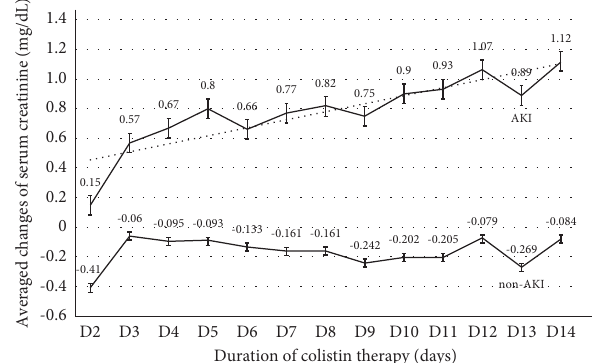
Figure 2: Means of serum creatinine changes from baseline levels in the AKI and non-AKI groups during 2 weeks of colistin